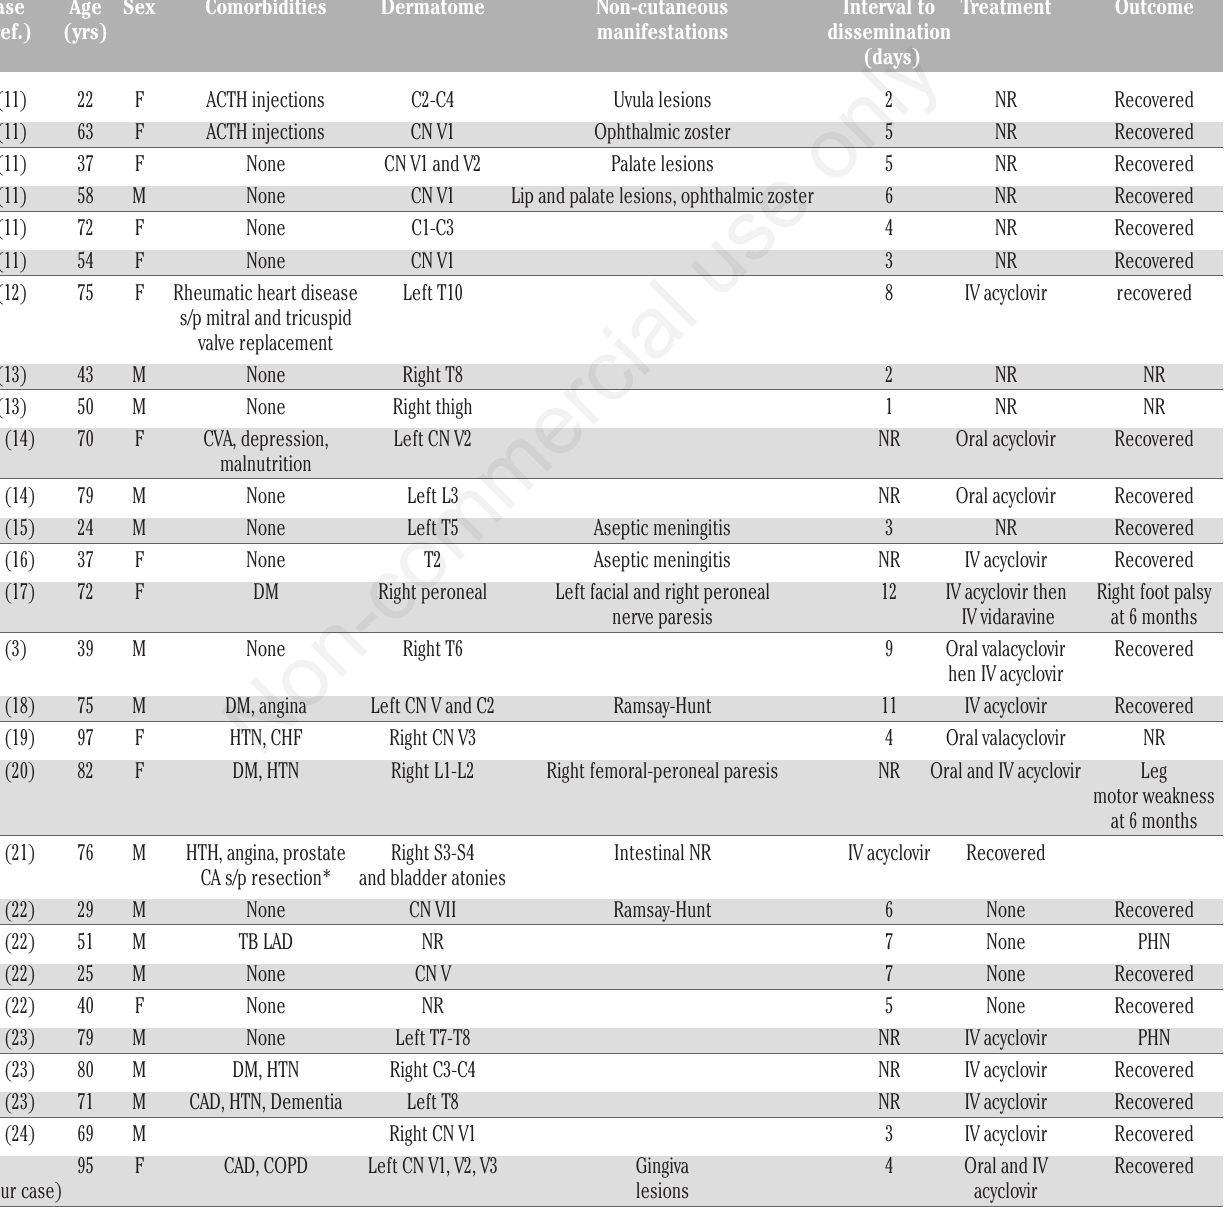
Table 1. Characteristics of patient with disseminated cutaneous herpes